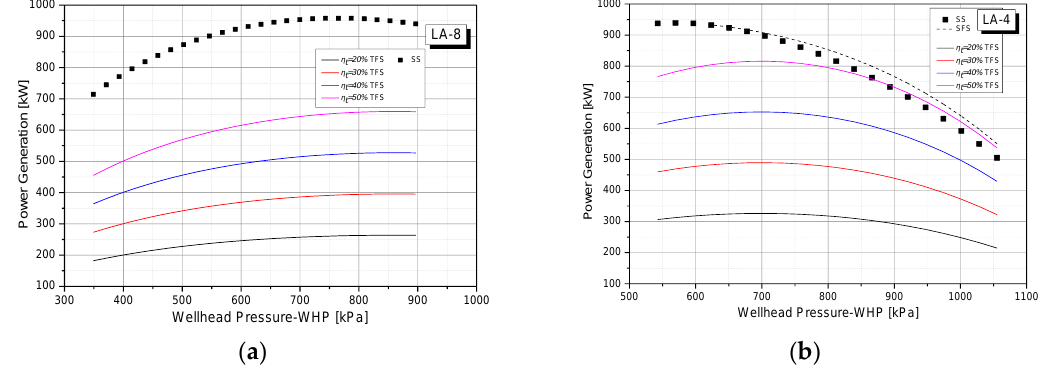
Figure 4. Power generation against wellhead pressure of ( a ) LA-8 and ( b ) LA-4.